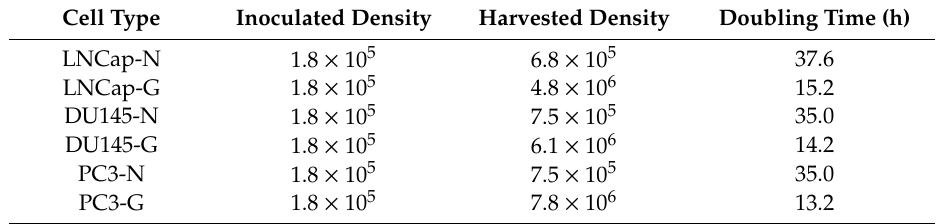
Table 1. The inoculated and harvested densities and doubling times of glycidamide-treated prostate cancer